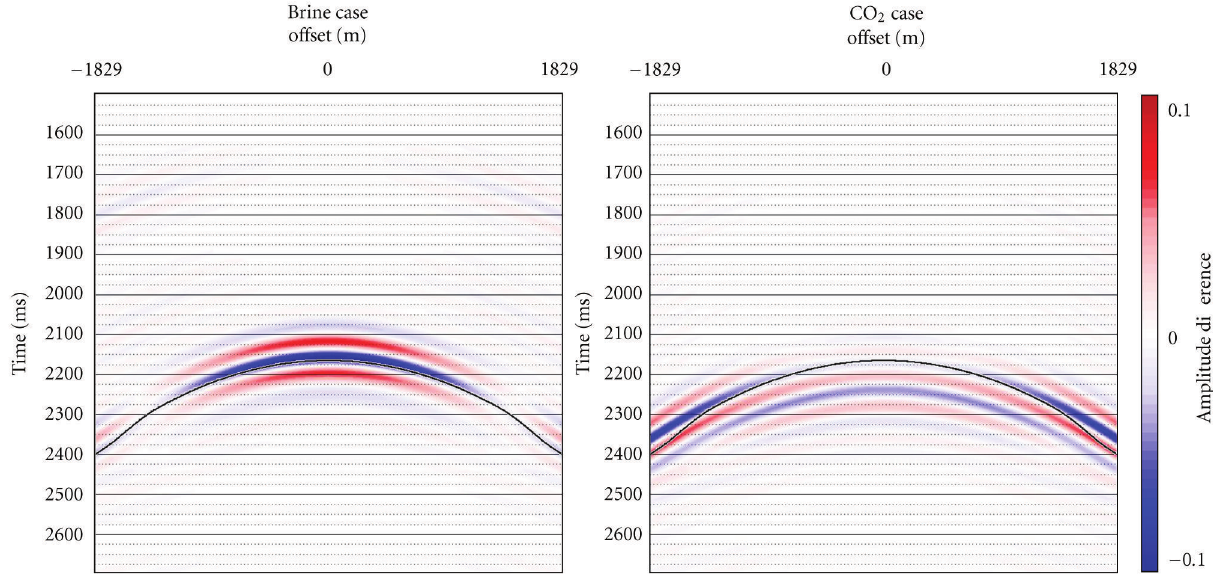
Figure 20: Comparison of the S-wave amplitude di ff erence for the brine- and CO 2 -saturated cases with a pore pressure increase from 6.89MPa to 29.65 MPa. The Morrow A sandstone top is indicated by the black